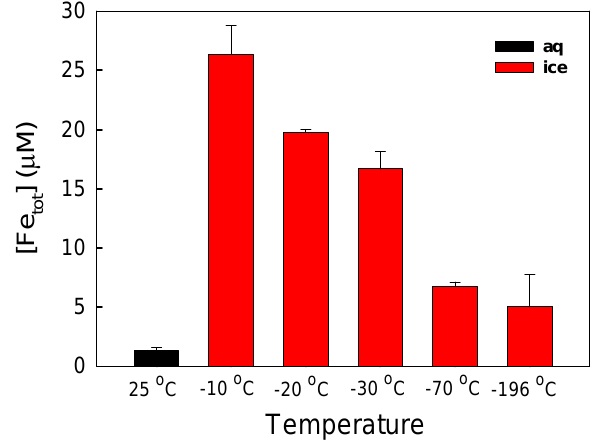
Fig. 5. Temperature dependence of iron dissolution from maghemite in the absence of organic complexing ligand. Aqueous samples (black) were maintained at room temperature and ice samples (red) at -10 o C, -20 o C, -30 o C, -70 o C, and -196 o C. Experimental conditions: [ γ - Fe 2 O 3 ] i = 0.2 g L -1 and pH i = 3.00 ± 0.05.